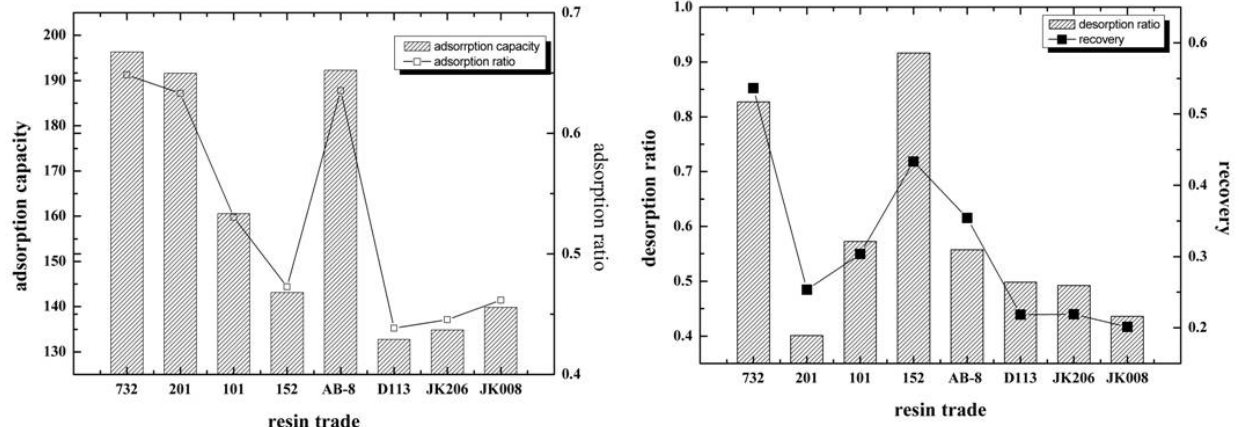
Figure 2. Adsorption capacity, adsorption ratio, desorption ratio and recovery of 1-DNJ with different